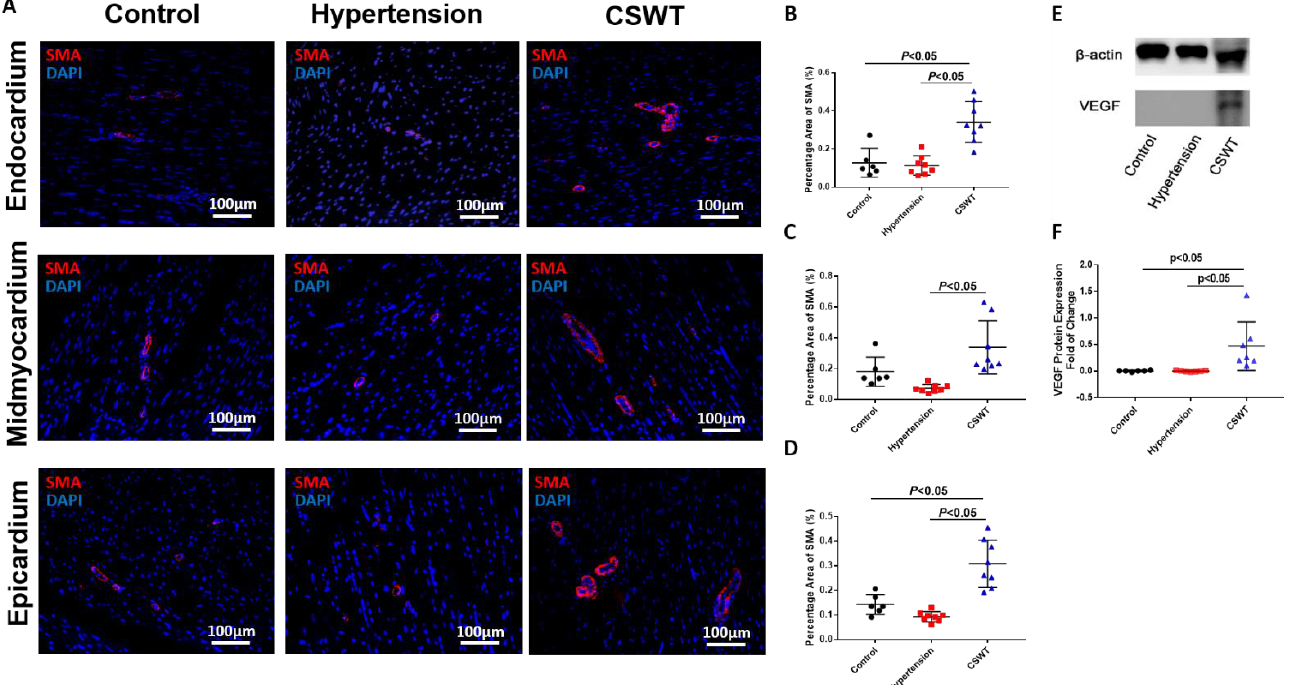
Figure 5. Angiogenesis effect of CSWT at the 20th week. Immunohistological staining of heart sections in the three groups at the 20th week. ( A ). Microvascular density in endocardium, midmyocardium and epicardium were assessed by immunofluorescence staining with SMA (smooth muscle actin) in the three groups. ( B – D ). There were no significant differences of positive − SMA staining in hypertension group compared with control group among three layers of myocardium. Additionally, CSWT significantly improved SMA − positive microvascular density compared with hypertension group in three layers of myocardium. ( E ). Representative Western blot analysis of VEGF (vascular endothelial growth factor) expression in three groups at the 20th week. ( F ). VEGF was significantly higher in CSWT group compared with control and hypertension groups. There was no significant difference of VEGF expression between control and hypertension groups. Independent Student t -test was used.